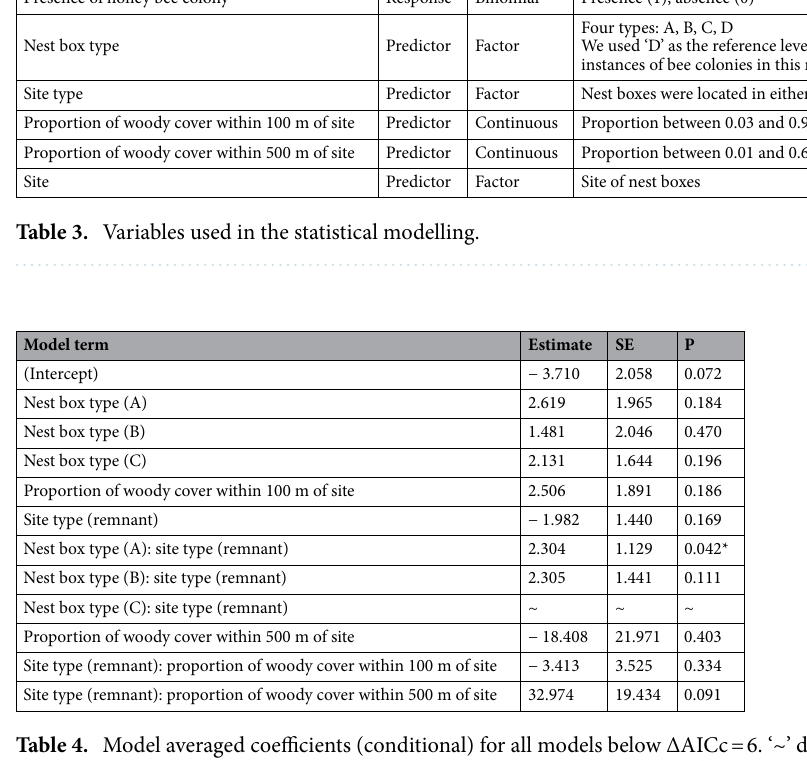
Table 4. Model averaged coefficients (conditional) for all models below ΔAICc = 6. ‘~’ denotes that term is rank-deficient (i.e., there were no data for this term). We used nest box type ‘D’ and site type ‘planting’ as factor reference levels. P probability, SE standard